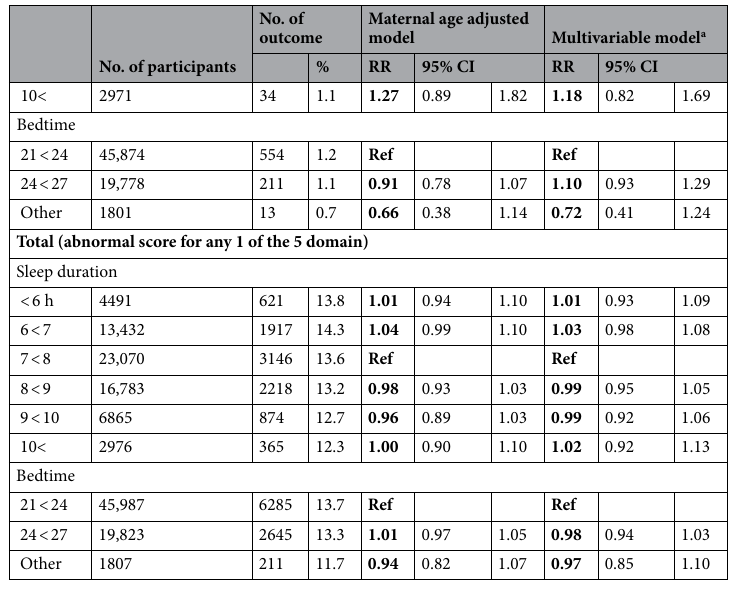
Table 4. Association between sleep before pregnancy and infant development, Japan Environment and Children’s Study (2011–2014). CI confidence interval, RR risk ratio. Bold fonts showed the items of the Ages and Stages Questionnaire. a Adjusted for maternal age at delivery, smoking habits, alcohol consumption, pre- pregnancy body mass index, gestational age at birth, parity, infertility treatment, and infant